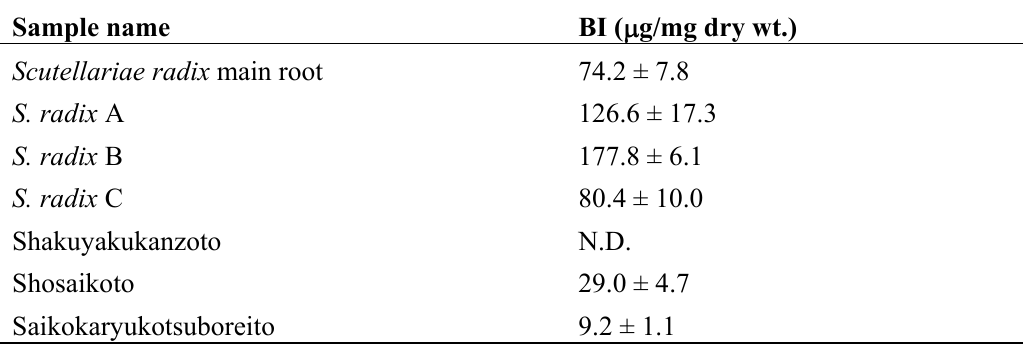
Table 1. The concentration of BI in S. radix es and KMs determined by